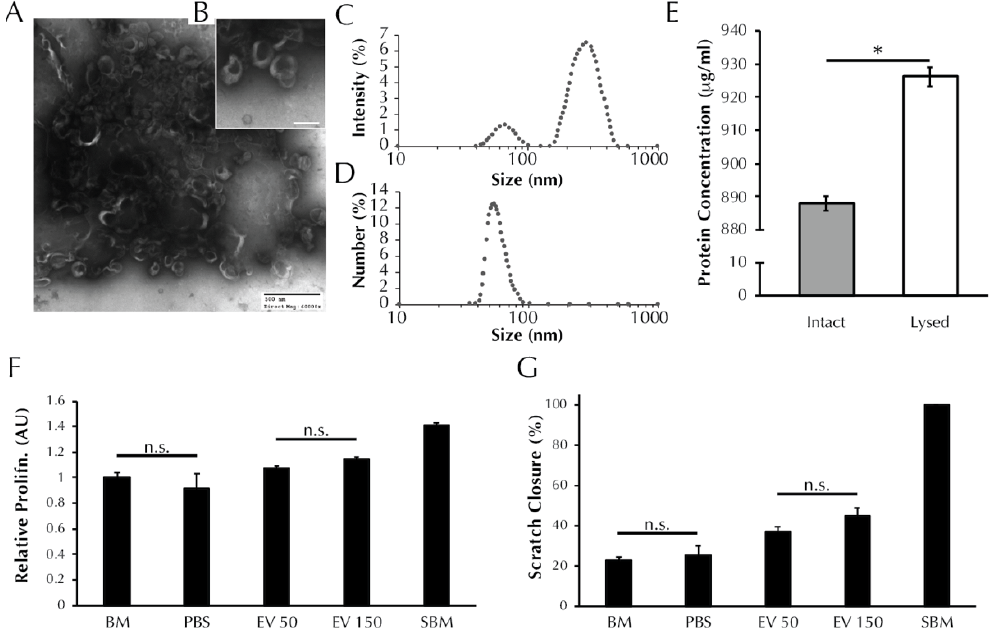
Figure 1. EV isolates are characterized by the presence of exosome-like particles and have a positive effect on both SMC proliferation and migration. ( A ) TEM images of ASC secreted EVs visible at 60× and ( B ) 150× magnification resolutions. Black shadowing is free protein present within the EV isolate resuspension. ( C ) Size distribution of particles within the EV isolate as determined using dynamic light scattering in terms of intensity and ( D ) number of readings. ( E ) Total protein content of the EV isolate before and after lysis (* = p < 0.0001 by t -test). ( F ) SMC proliferation and ( G ) migration after treatment with unsupplemented basal media (BM), PBS vehicle control, or increasing concentrations of EVs (50 or 150 µL). Aside from pairs marked with “n.s.” all pairs were significantly different by one-way ANOVA, p < 0.05.